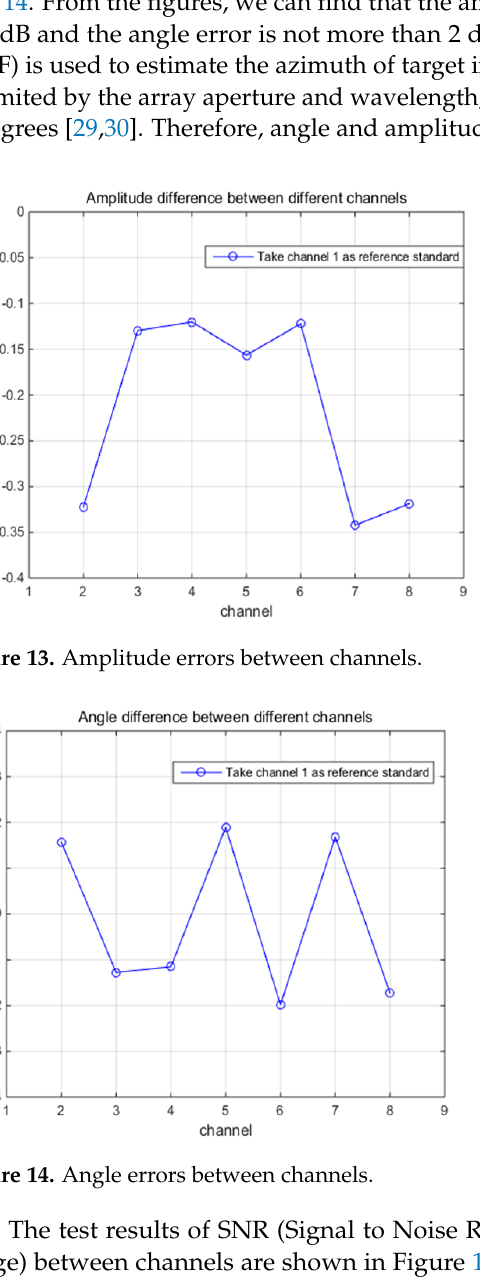
Figure 15. SNR and SFDR of acquisition system. Figure 16. Waveform of echo signal. 5. Discussion As depicted by test results given in Section 4, the designed acquisition card can meet the requirements of real-time processing and accurate transmission of echo signals in a new acquisition and transmission framework of high-frequency ground-wave radar